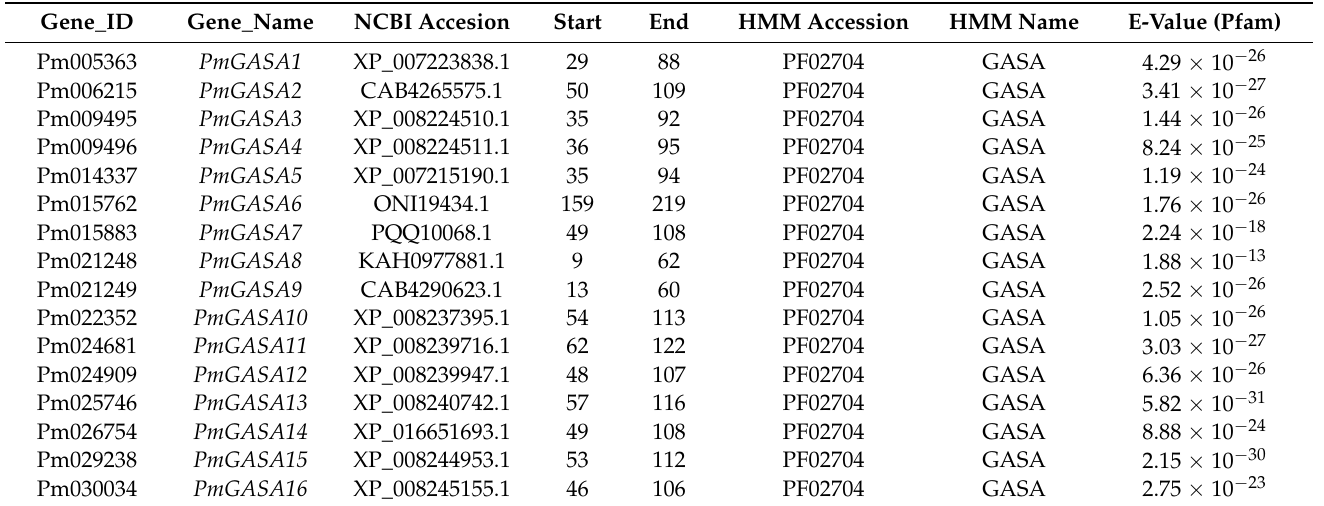
Table 1. Detailed information of GASA family genes identified in P. mume . For each gene, their Gene_ID (gene identifier in the published genome of P. mume ), NCBI accession (closest gene accession name returned from NCBI BLASTP), the start and end coordinate of GASA domain, HMM accession ID, domain name, and e-value for each PmGASA protein query in the Pfam database are